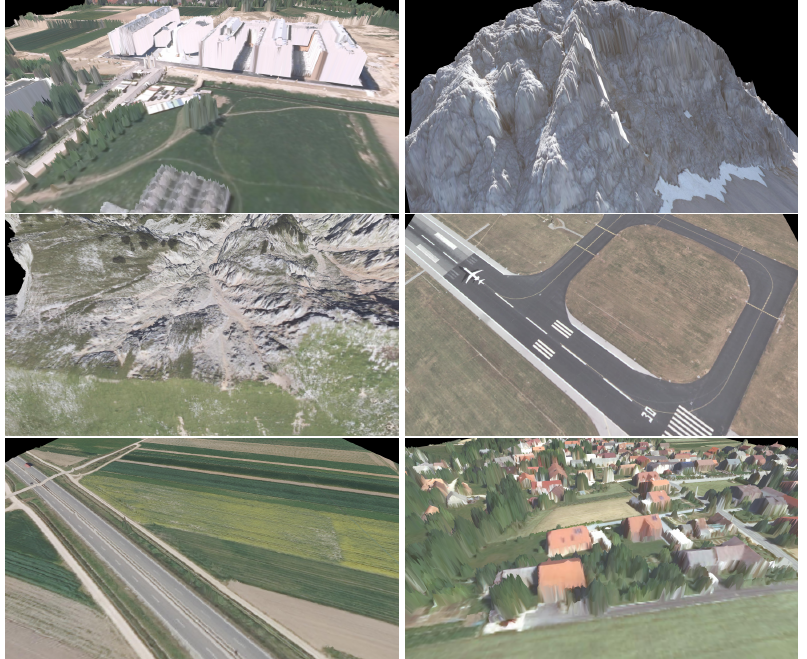
Figure A1. Test scenes used in performance evaluation. ( Top left ) complex building; ( top right ) high mountain; ( middle left ) broad mountain region; ( middle right ) airport; ( bottom left ) flat land; and ( bottom right ) a residential region with houses and